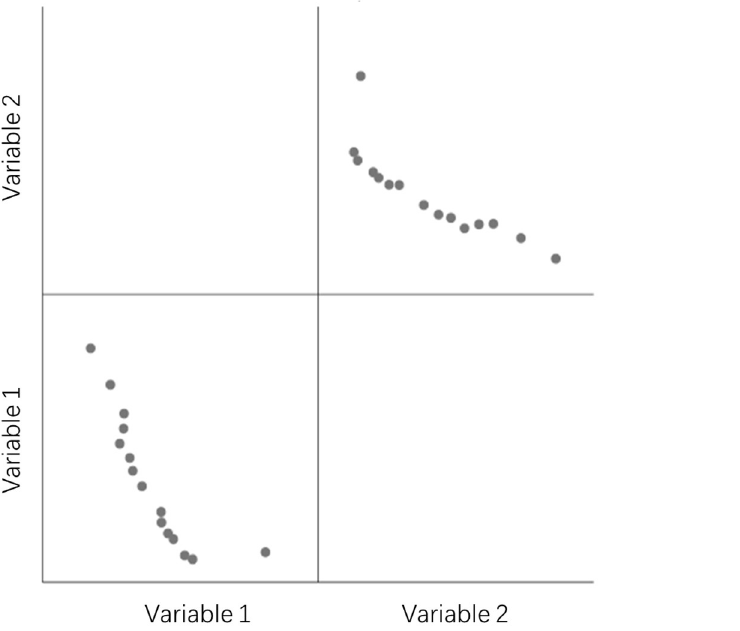
Fig 3. Scatterplot of principal component